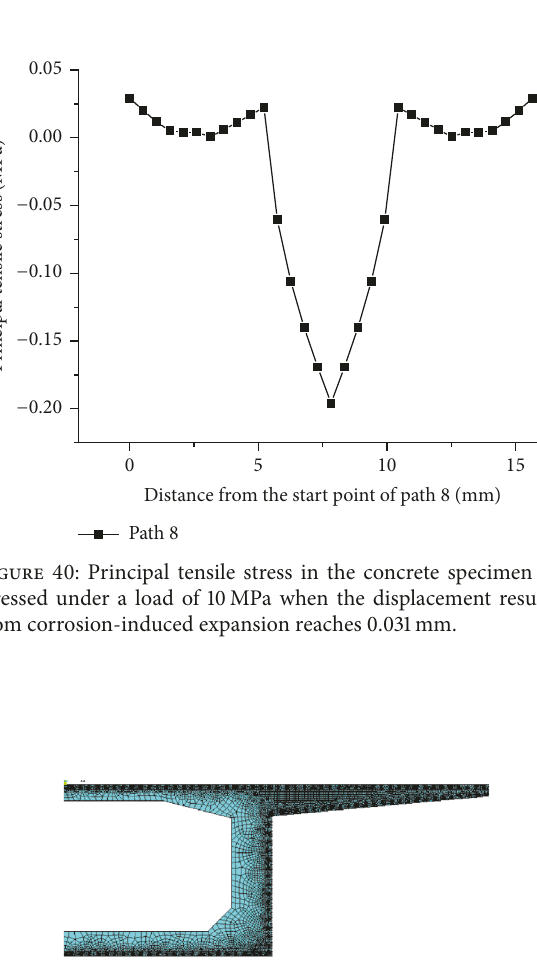
Figure41:Elementmeshgenerationforthetransversecross-section of half of an actual